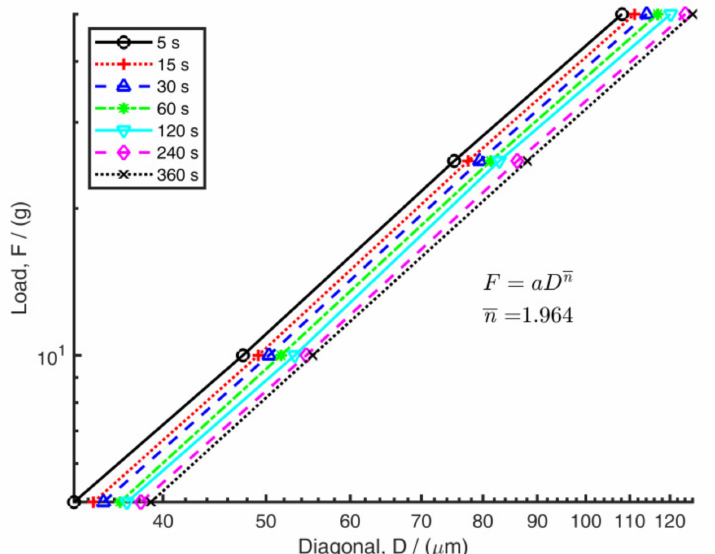
Figure 6. ( a ) Relationship between hardness value and dwell time for four load levels and ( b ) relationship between hardness value and load for seven dwell times. Trendlines connecting the data points are shown.